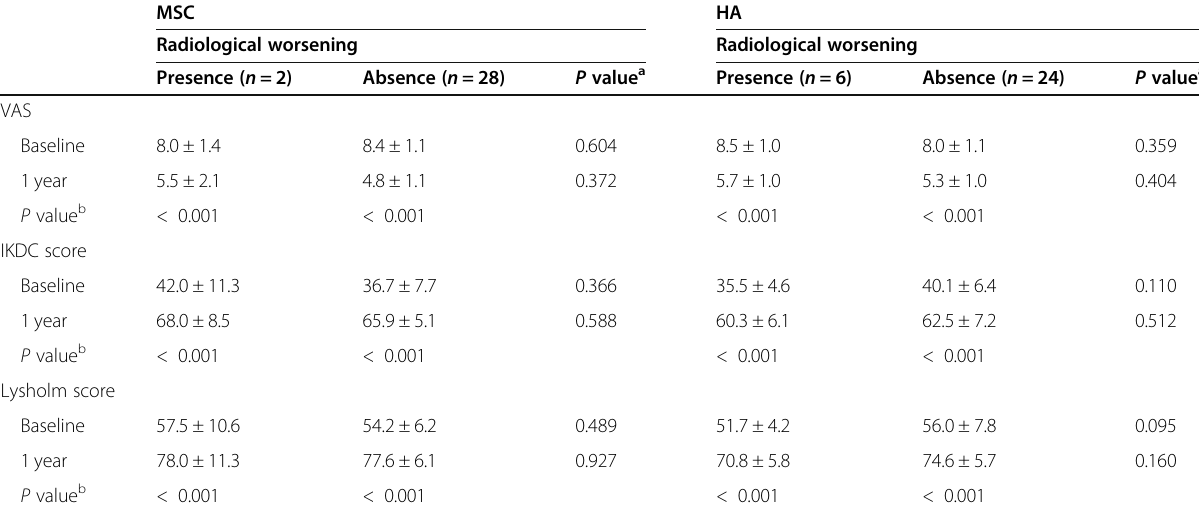
Table 3 Comparison of preoperative and postoperative clinical outcomes according to the presence of radiological worsening in both